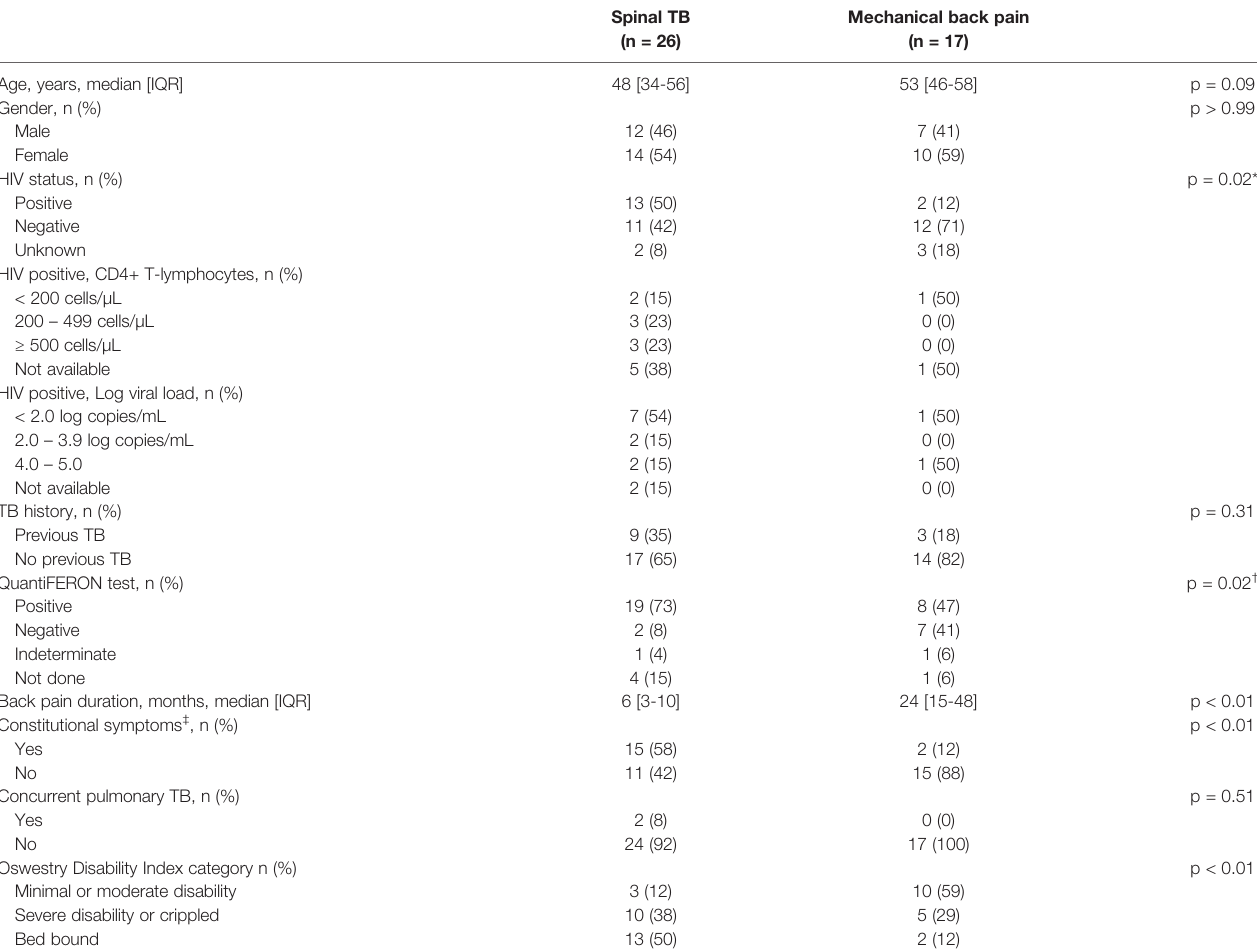
TABLE 2 | Participant characteristics and clinical